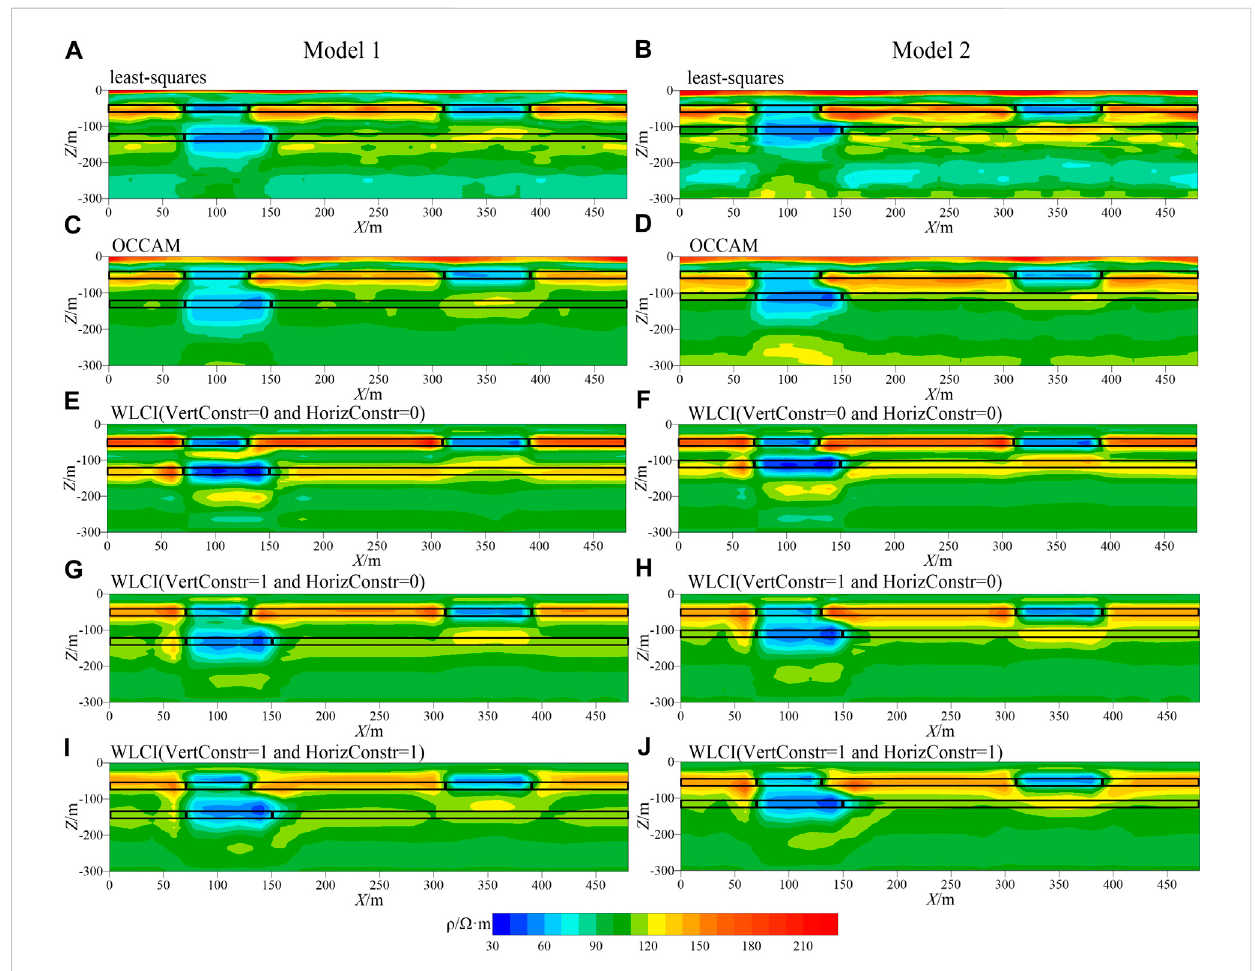
FIGURE 8 Inversion results of Model 1 and Model 2. (A) : least-squares inversion result of model 1. (B) : least-squares inversion result of model 2. (C) : OCCAM inversion result of model 1. (D) : Occam inversion result of model 2. (E) : WLCI inversion result of model 1 while vertical constrained factor is 0 and horizontal constrained factor is 0. (F) : WLCI inversion result of model 2 while vertical constrained factor is 0 and horizontal constrained factor is 0. (G) : WLCI inversion result of model 1 while vertical constrained factor is 1 and horizontal constrained factor is 0. (H) : WLCI inversion result of model 2 while vertical constrained factor is 1 and horizontal constrained factor is 0. (I) : WLCI inversion result of model 1 while vertical constrained factor is1 and horizontal constrained factor is 1. (J) : WLCI inversion result of model 2 while vertical constrained factor is 1 and horizontal constrained factor is